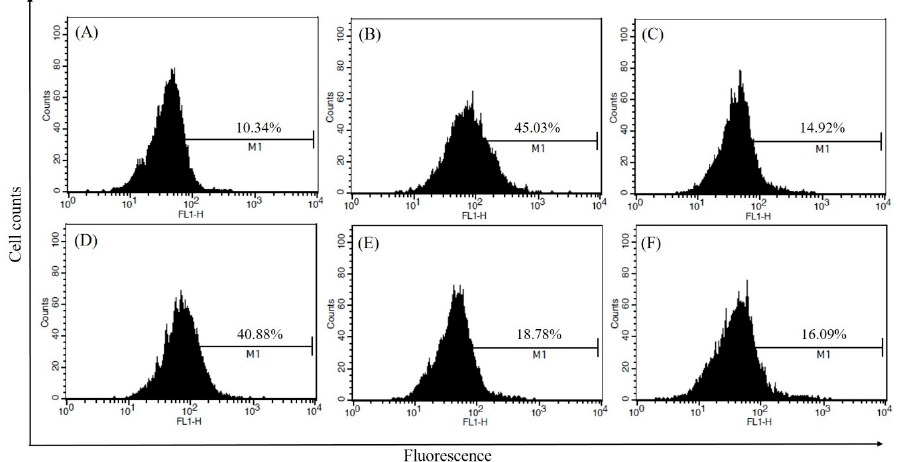
Figure 5. Intracellular ROS determination using DCF-DA on the LPS-stimulated RAW264.7 macrophages. ( A ) Control; ( B ) LPS; ( C ) LPS + NAC (20 mM); ( D ) LPS + CSLE (50 μ g/mL); ( E ) LPS + CSLE (100 μ g/mL) ( A ) Control; ( B ) LPS; ( C ) LPS + NAC (20 mM); ( D ) LPS + CSLE (50 µ g/mL); ( E ) LPS + CSLE (100 µ g/mL) and ( F ) LPS + CSLE (200 μ g/mL). and ( F ) LPS + CSLE (200 µ